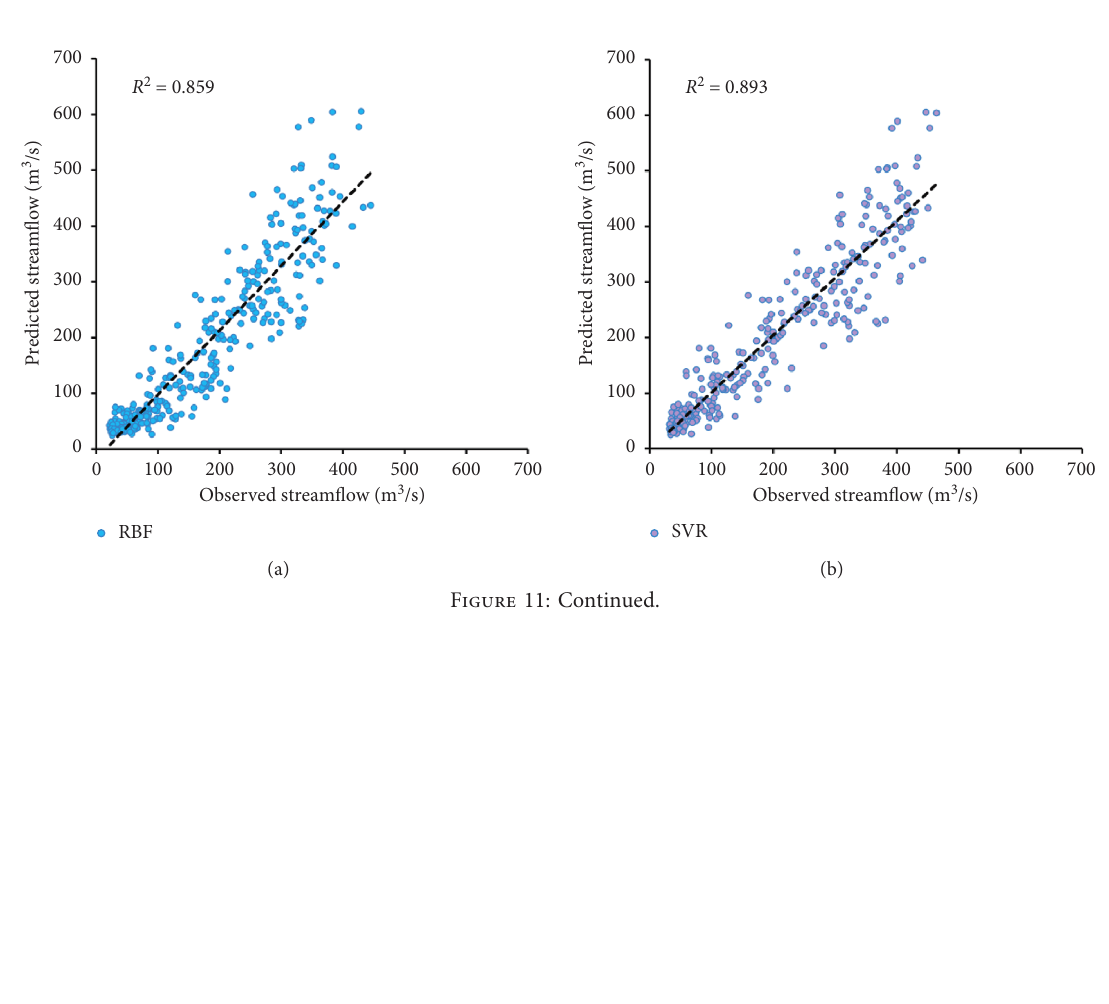
Figure 10: Observed and predicted streamflow using RBF, SVR, RFR, GRU, LSTM, ICEEMDAN-LSTM, VMD-LSTM, and IVL models during the testing